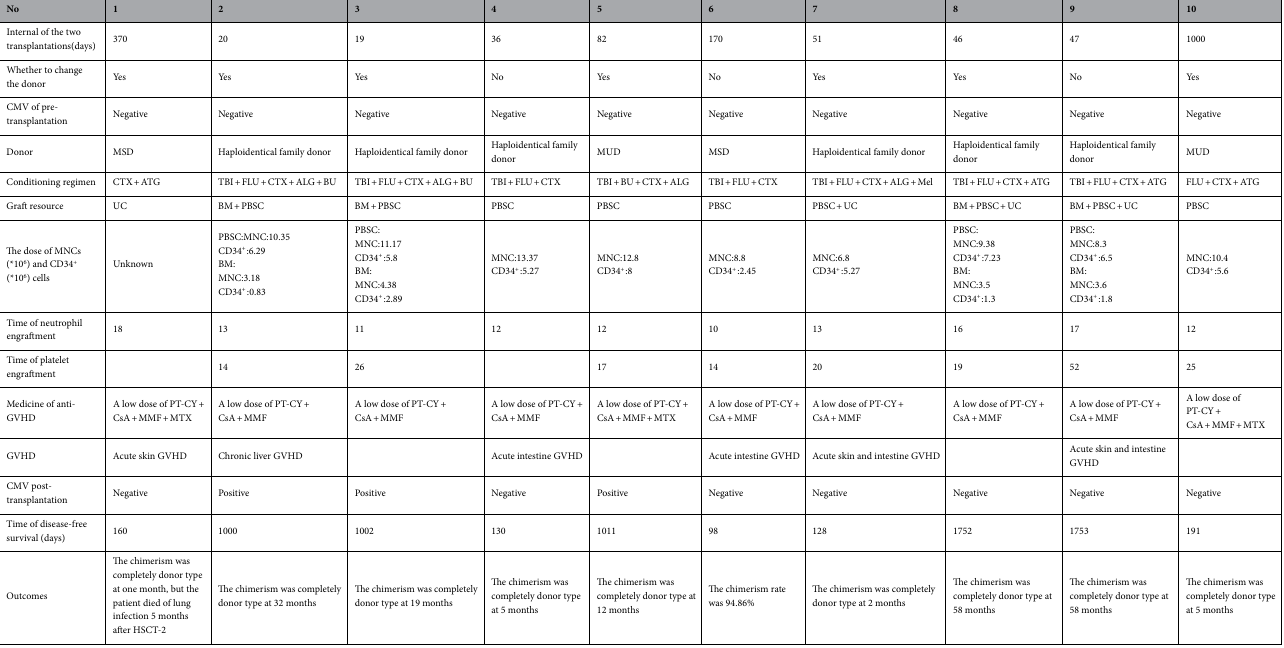
Among the 10 patients, 7 patients changed their donor. Among the 7 patients, 4 underwent family-haploi- dentical donor HSCT. Among the 3 patients who did not change donors, 2 were still using family-haploidentical matched family donors, MSDs, and MUDs were 14 days, 14 days, and 12 days, respectively. The average platelet engraftment times were 26 days, 14 days, and 21 days, respectively. The conditioning regimen depended on the status of the patients. According to the Center for International Blood and Marrow Transplant Research (CIBMTR) guidelines, all patients received NMAs. To achieve the better efficacy, a low dose of TBI was applied in 8 patients, and 3 used a low dose of Bu, and only a patient used Mel. The 6 patients who used haploidentical-matched family donors, all received 2 ~ 3 Gy TBI, 2 of them used Bu, and only one patient used Mel. Among the 4 patients who used MSDs or MUDs, 2 patients received 2 ~ 3 Gy TBI. The average time of neutrophil engraftment was 13.0 days in the 8 patients (ranging from 10.0 days to 17.0 days). The average time of platelet engraftment was 23 days (ranging from 14.0 days to 52 days). In the other 2 patients, the average times of neutrophil and platelet engraftment were 15.0 days and 25.0 days, respectively. With an average follow-up of 722.5 days (ranging from 98 to 1753 days), 9 patients were alive, and one patient died from lung infection after 5 months after HSCT-2. Including the deceased patient, a total of 3 patients were diagnosed with poor graft function (PGF) because frequent platelet transfusion was needed when excluding disease relapse, the influence of drugs, infection and other explanations 5 . Low doses of PT-CY and MMF were used in all the 10 patients to prevent acute and chronic GVHD. Given that the graft resources were mainly from peripheral blood, to deplete the T lymphocytes in the stem cells, 3 patients additionally received MTX. However, 4 patients suffered from acute GVHD, including grade I-II acute skin, oral and/or intestinal GVHDs. Only one patient had chronic skin GVHD. In addition, tacrolimus was continually used to treat GVHD. Thirty days after HSCT-2, all patients were evaluated for donor chimerism, 9 patients showed full chimerism, and one patient showed mixed donor chimerism 5 . There was no patient suffer- ing from GF after HSCT-2. Apart from these, all the patients tested the copy number of cytomegalovirus (CMV) before and after trans- plantation. None of them were positive before HSCT-2 but there were 3 patients suffered from CMV reactivation. Foscarnet and human Immunoglobulin (pH4) were used to treat CMV infection. And the results turned to be negative after two weeks on average.